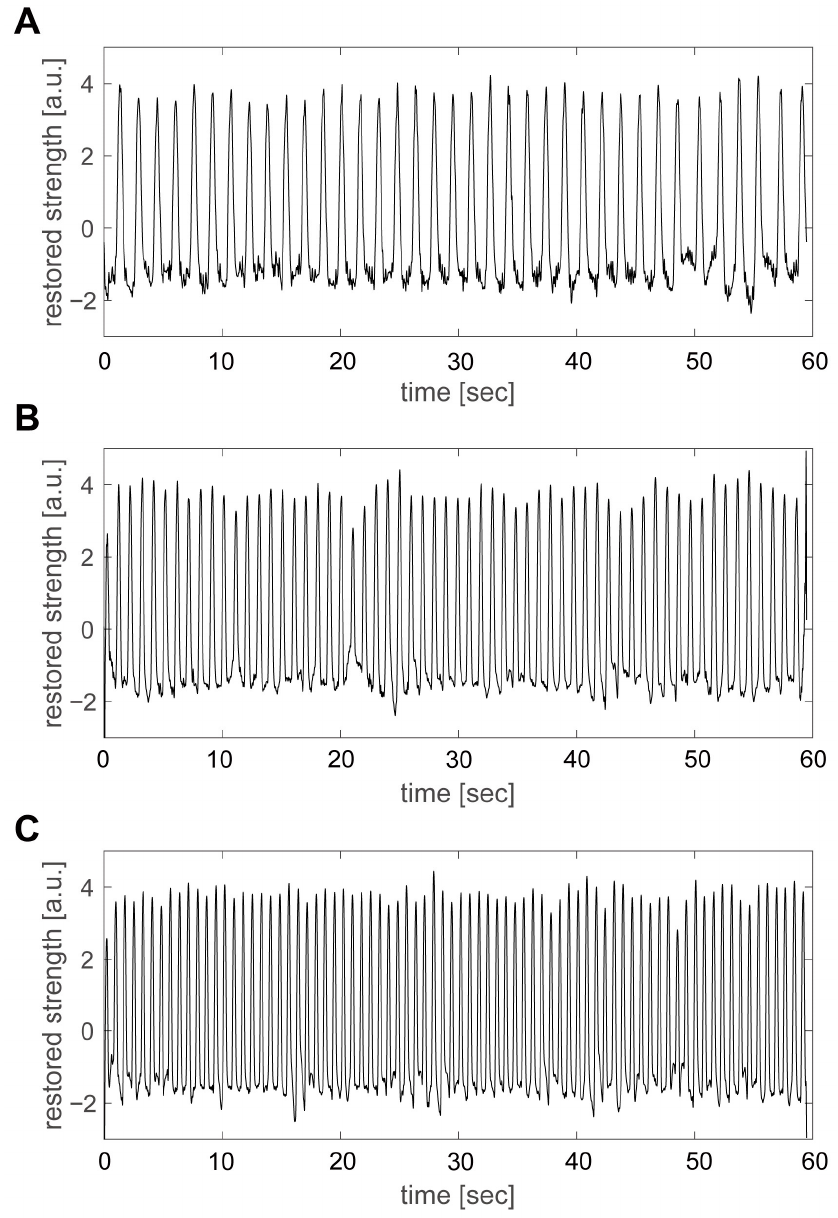
Figure 6. Pulsation of group D at various temperatures. ( A ) 28 ◦ C, 0.5–10 Hz; ( B ) 32 ◦ C, 0.8–10 Hz; ( C ) 36 ◦ C, 0.8–10 Hz. For the pulsation of other cell groups, see the Supplementary Materials.